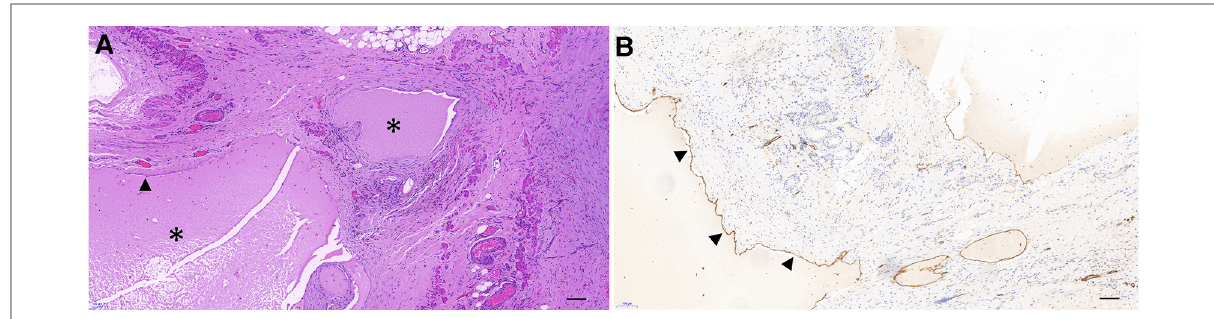
FIGURE 5 Pathological and immunohistochemical staining of MCs (×100). ( A ) Multiple cysts are lined with a single layer of fl attened endothelium (arrowhead), fi lled with eosinophilic proteinaceous material (asterisk). ( B ) Immunohistochemical staining showing that the endothelium exhibited a positive expression of D2-40. (Bar: 100 μ